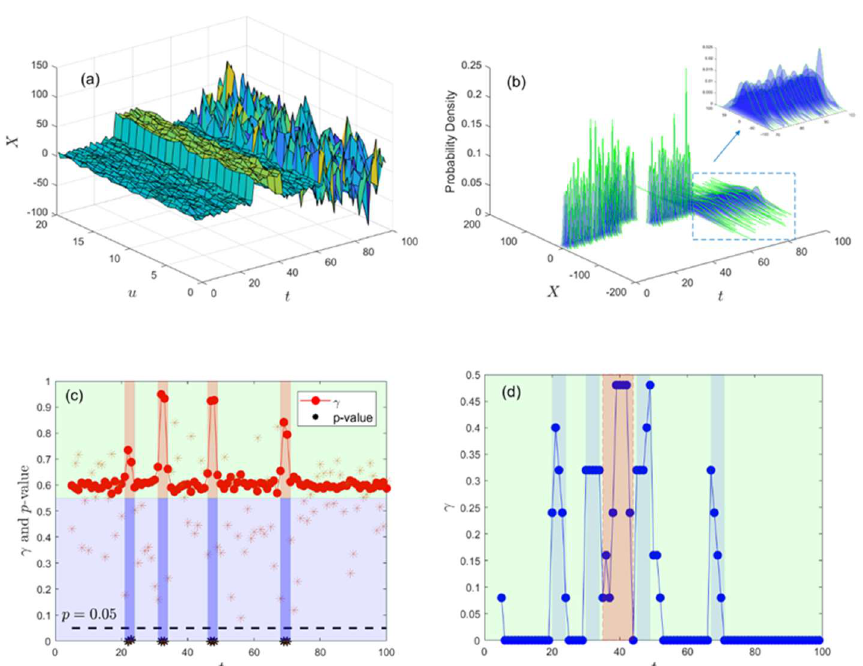
Figure 2. Identification results of breakpoints in simulation data: ( a ) simulation data; ( b ) kernel density estimation results; ( c ) identification results based on PDRN; ( d ) identification results based on traditional recurrence network.